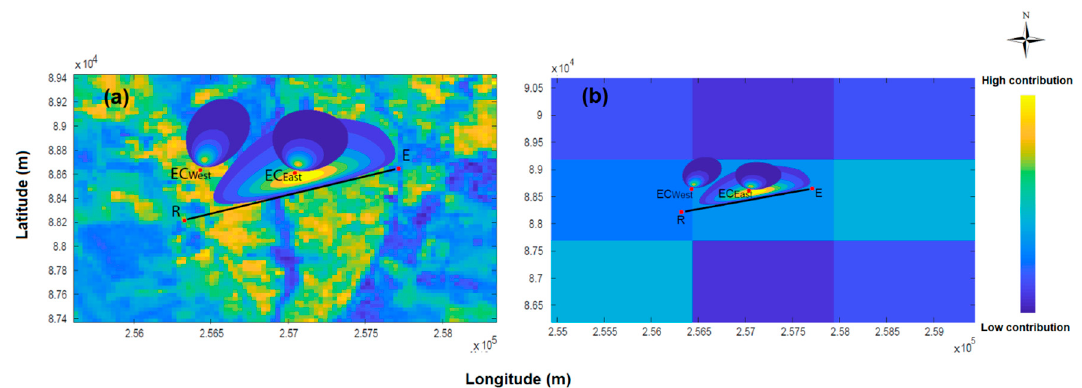
Figure 10. Footprint of the LAS computed using the footprint model of Horst and Weil superimposed on a surface temperature images derived from Landsat ( a ) and MODIS ( b ).